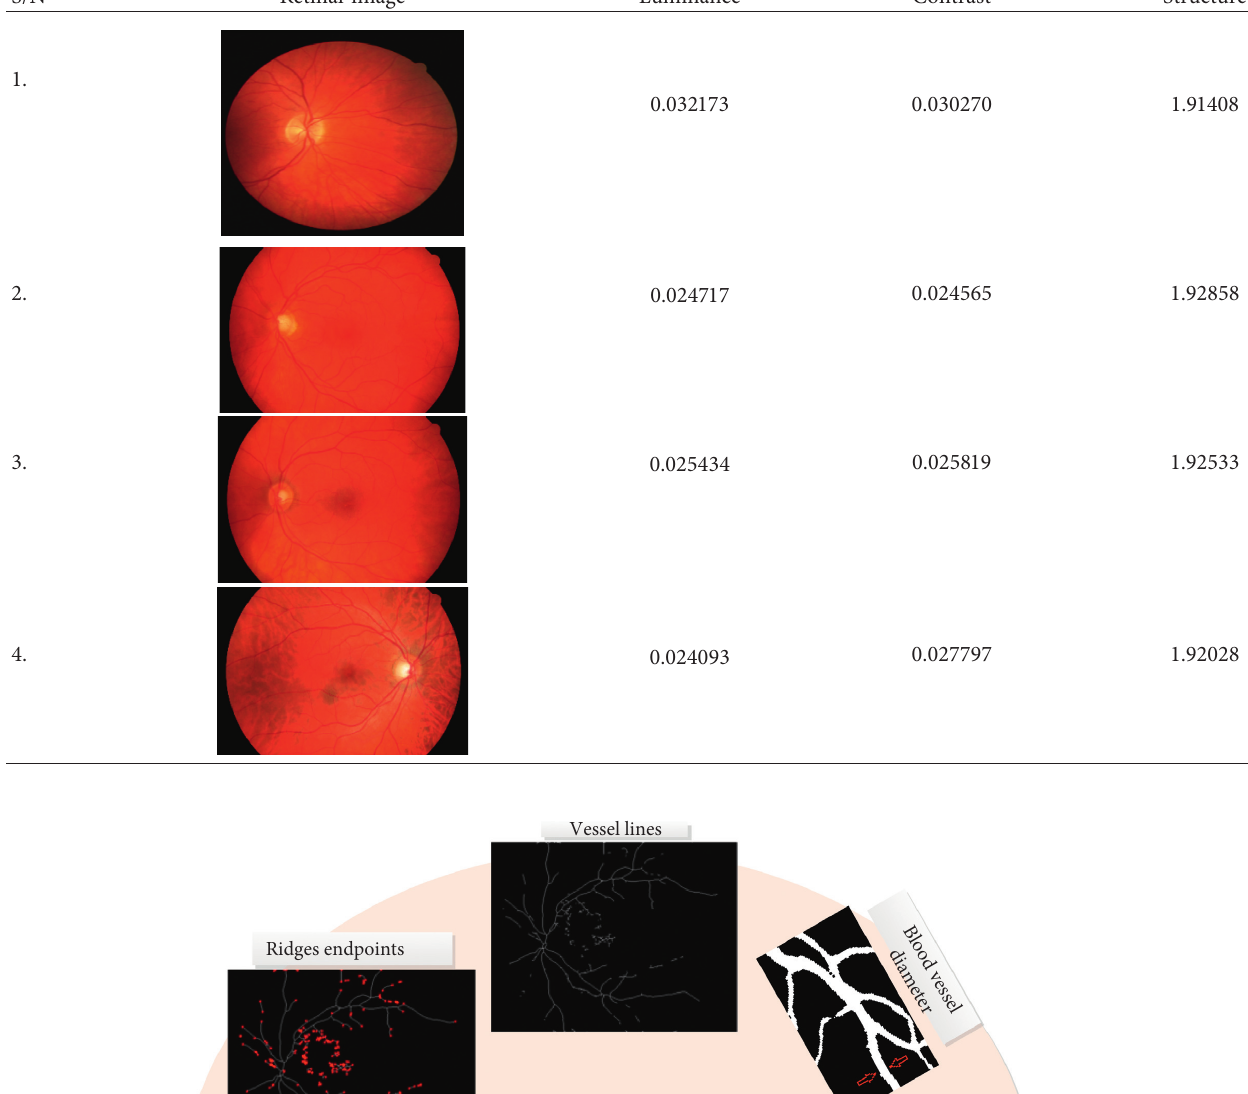
Table 2: Structural features computed from selected healthy retinal images.